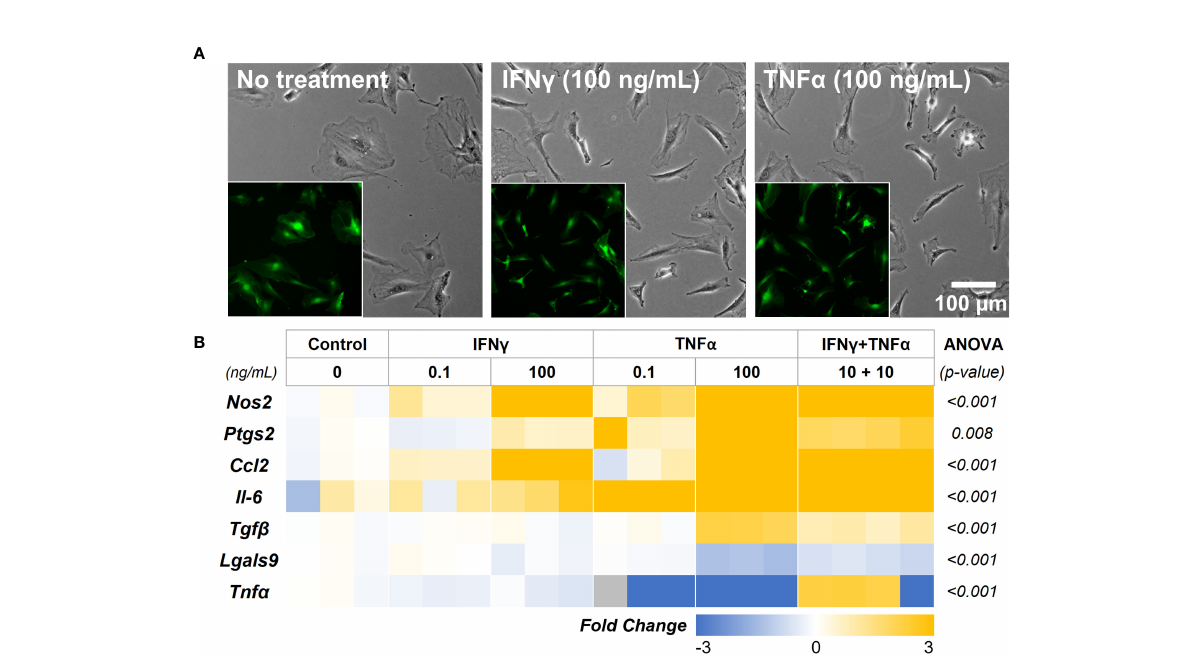
FIGURE 4 AD-MSC Licensing and their Immunomodulatory Phenotype. (A) Phase-contrast images of AD-MSC control and treatment conditions after 12 hours. (Insets) Corresponding fl uorescent images of the cells show minimal differences in morphology and viability. (B) Heatmap of the AD-MSC gene expression after 12 hours of licensing using low and high concentrations of IFN g and TNF a . Heatmaps show fold change with respect to the housekeeping gene (Gapdh) and untreated